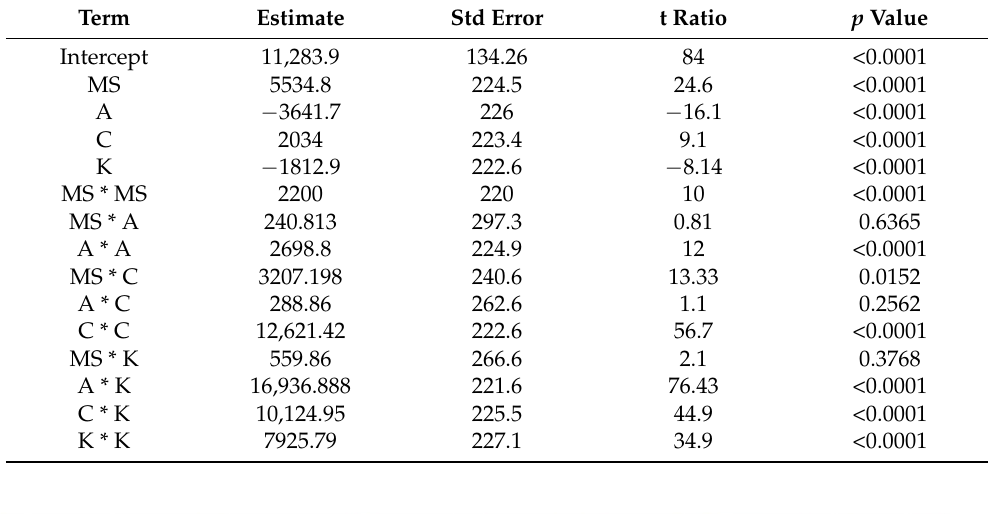
Table 2. Parameter estimates of response surface model effects.